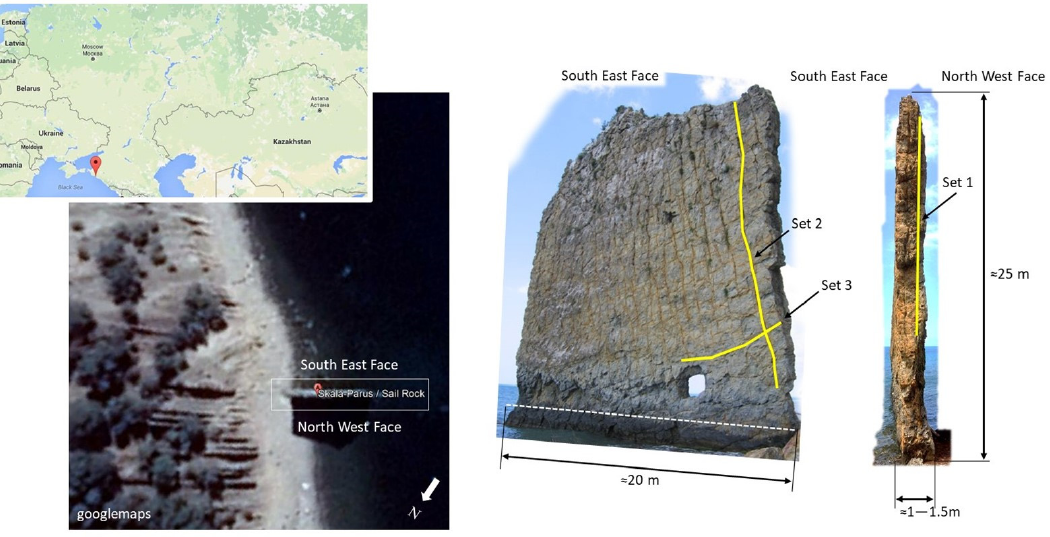
Figure 14. Parus Rock. Data from GoogleMaps and photos shared under a creative common license CC2.5.